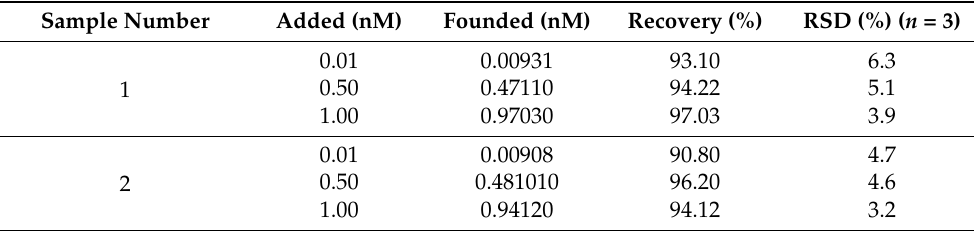
Table 3. Determination of target microRNA let-7a in clinical serum specimens.